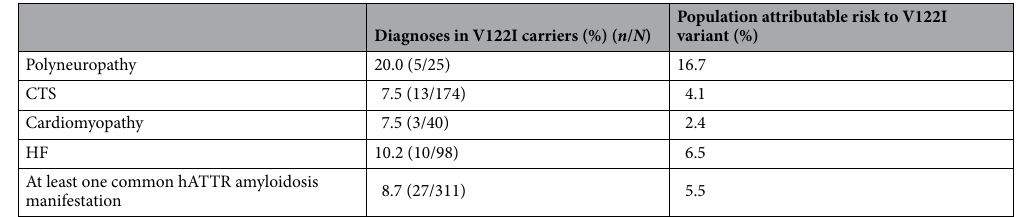
Table 3. Attributable risk of common hATTR amyloidosis manifestations in the UK Biobank African ancestry population ( n = 6062) due to the V122I variant.